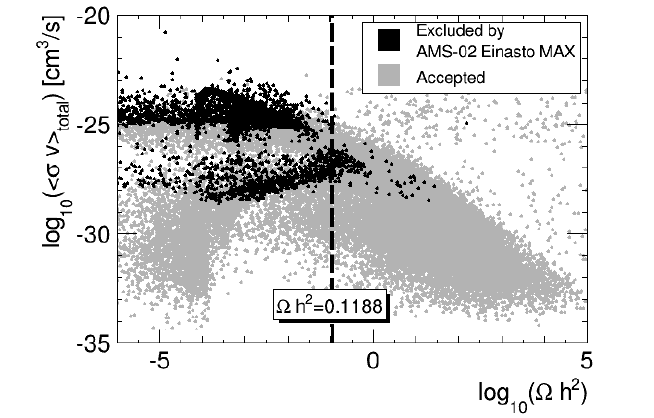
Figure 9 . Total annihilation cross section as a function of the relic density. The vertical dashed line corresponds to the central value of the Planck dark matter